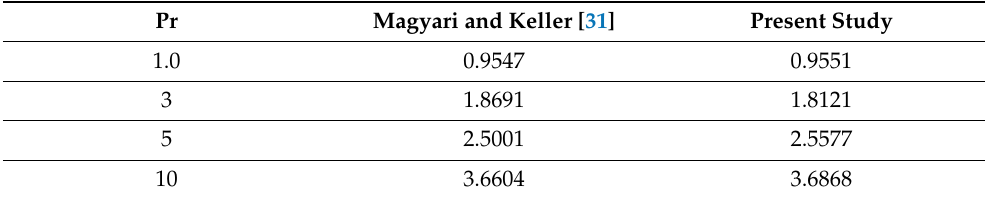
Table 1. Comparison of results for − θ (cid:48) ( 0 ) when Ri = 0, N = 0, Sc = 0, M = 0, β = 0, L = 0, K = 0, K ∗ = 0, Fr = 0.